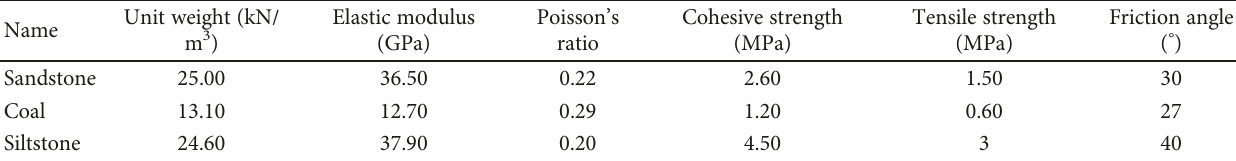
Table 1: Material properties of coal and roof strata.